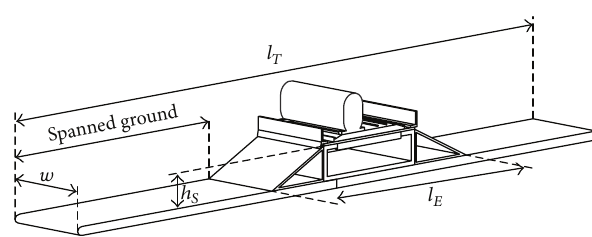
Figure 3: Sketch of the embankment model and the twin railway track equipped with windbreaks. The train coach model is located on the windward rail track. The embankment slope vertical length is ℎ 𝑆 = 80 mm. The length of the embankment is 𝑙 𝐸 = 𝑐 + 2𝑙 𝑆 . The width and length of the complete mock-up are 𝑤 = 200 mm and = 1600 mm, respectively. 𝑙 𝑇